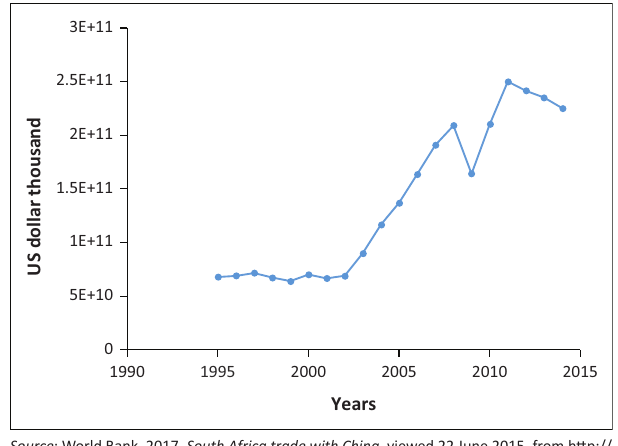
FIGURE 4: Time effects of trade between South Africa and